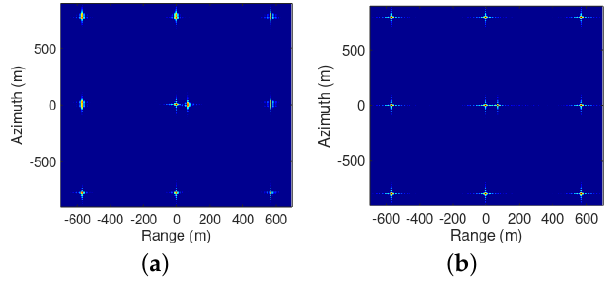
Figure 15. Comparison results of the proposed MoCo scheme and traditional MoCo techniques with signal s 9 . ( a ) Imaging result with traditional MoCo techniques. ( b ) Imaging result with the proposed MoCo